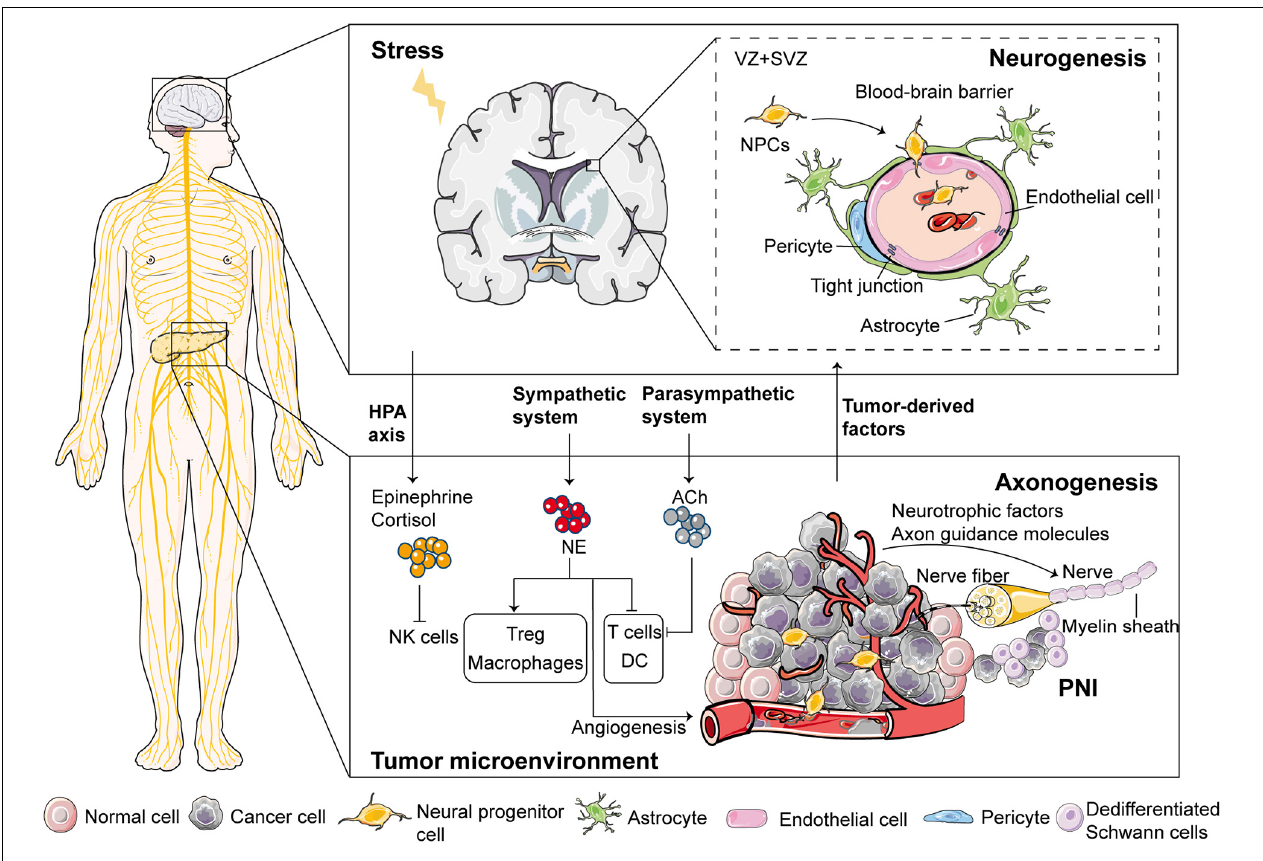
FIGURE 1 | Proposed mechanisms involved in the emergence of nerves in the tumor microenvironment. Regarding neurogenesis (i.e., increased number of neurons), the neural progenitor cells (NPCs) leave the subventricular zone (SVZ) and egress into circulation through the disrupted blood-brain barrier during cancer development. After reaching and infiltrating the primary tumor or metastatic tissues, these NPCs differentiate into new adrenergic neurons, which regulate tumor growth and metastasis. For axonogenesis (i.e., tumor-induced neural sprouting toward the tumor microenvironment), cancer cells and some stromal cells can enhance neuronal outgrowth and initiate tumor innervation through multiple mechanisms. Sympathetic nerves release NE while parasympathetic nerves release ACh in the tumor microenvironment, and are, therefore, involved in modulating immune responses. Moreover, stress regulates immune responses through two major neural pathways; the HPA axis and the sympathetic nervous system. Schwann cells can act as leading cells that actively dissociate, recruit, and guide cancer cells to neurites through heterocellular contact, thereby, leading to PNI. VZ, ventricular